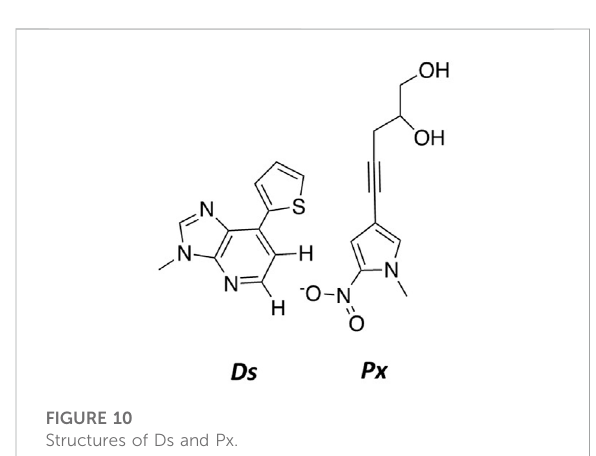
FIGURE 10 Structures of Ds and